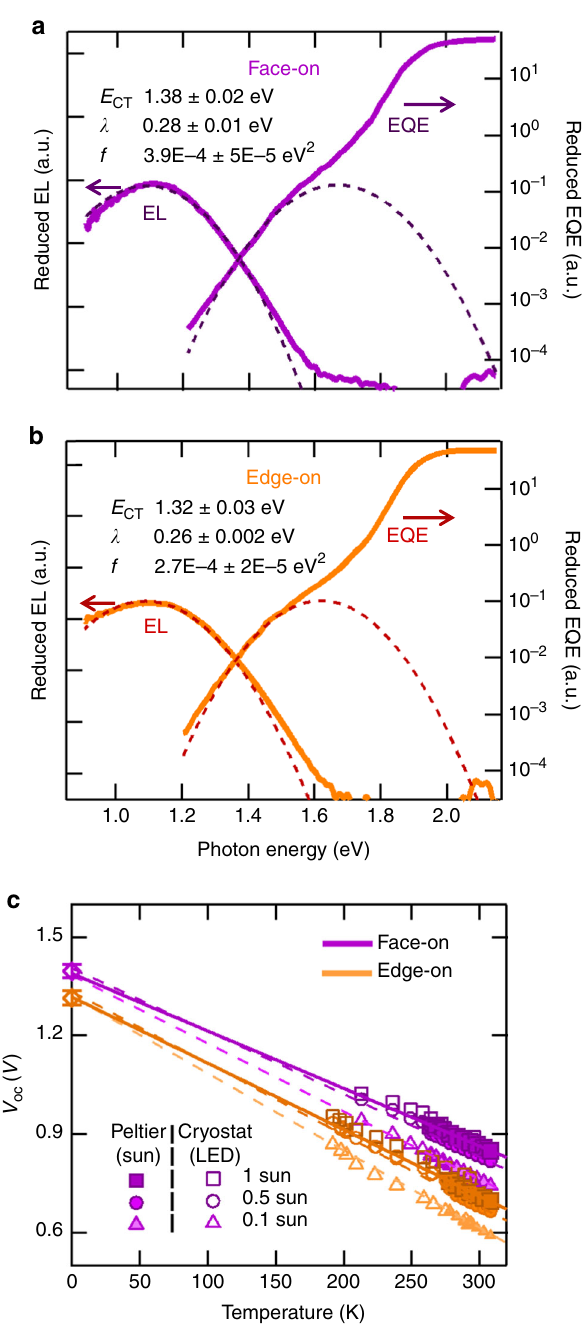
Fig. 3 Characterization of the CT state in the bilayers. a , b EQE spectra of the sub-bandgap absorption and the corresponding EL spectra for face-on ( a ) and edge-on ( b ) bilayers. Dashed lines are fi ts to the EQE using Eqs. 1 and 2. Fit parameters and their respective s.d. errors are reported in the fi gures. c Temperature-dependent V OC at 1, 0.5, and 0.1 suns, extrapolated to 0 K represented on the axis with the corresponding